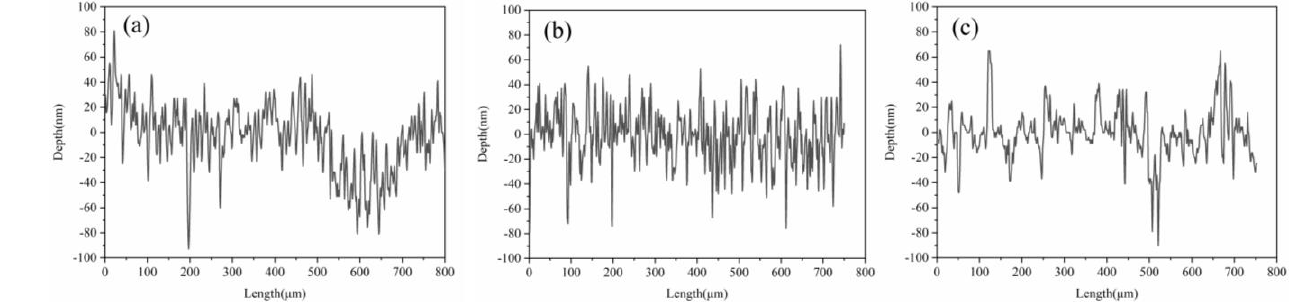
Figure 13. Surface roughness profile topography: ( a ) Ta substrate ( b ) TD film ( c ) TTTD film.